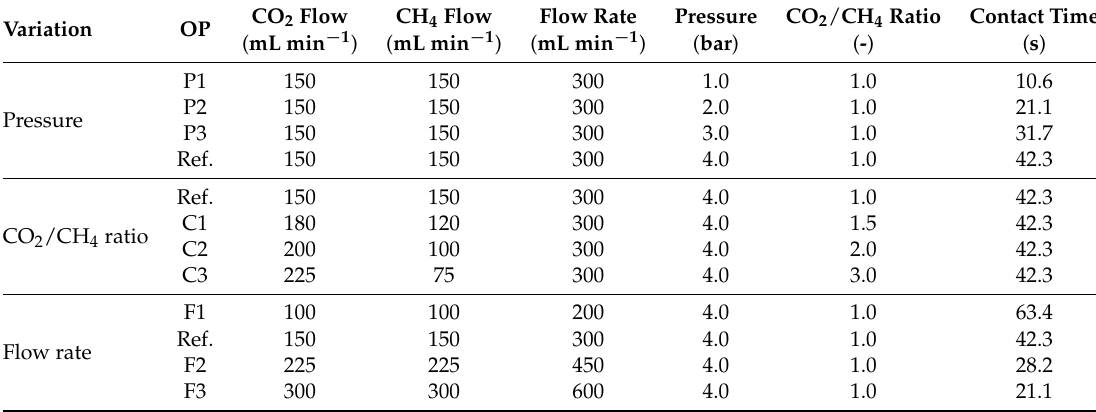
Table 1. Experimental settings for dry reforming parameter study, volumetric flow rates given at standard temperature and pressure p 0 = 1.013 bar, T 0 = 273